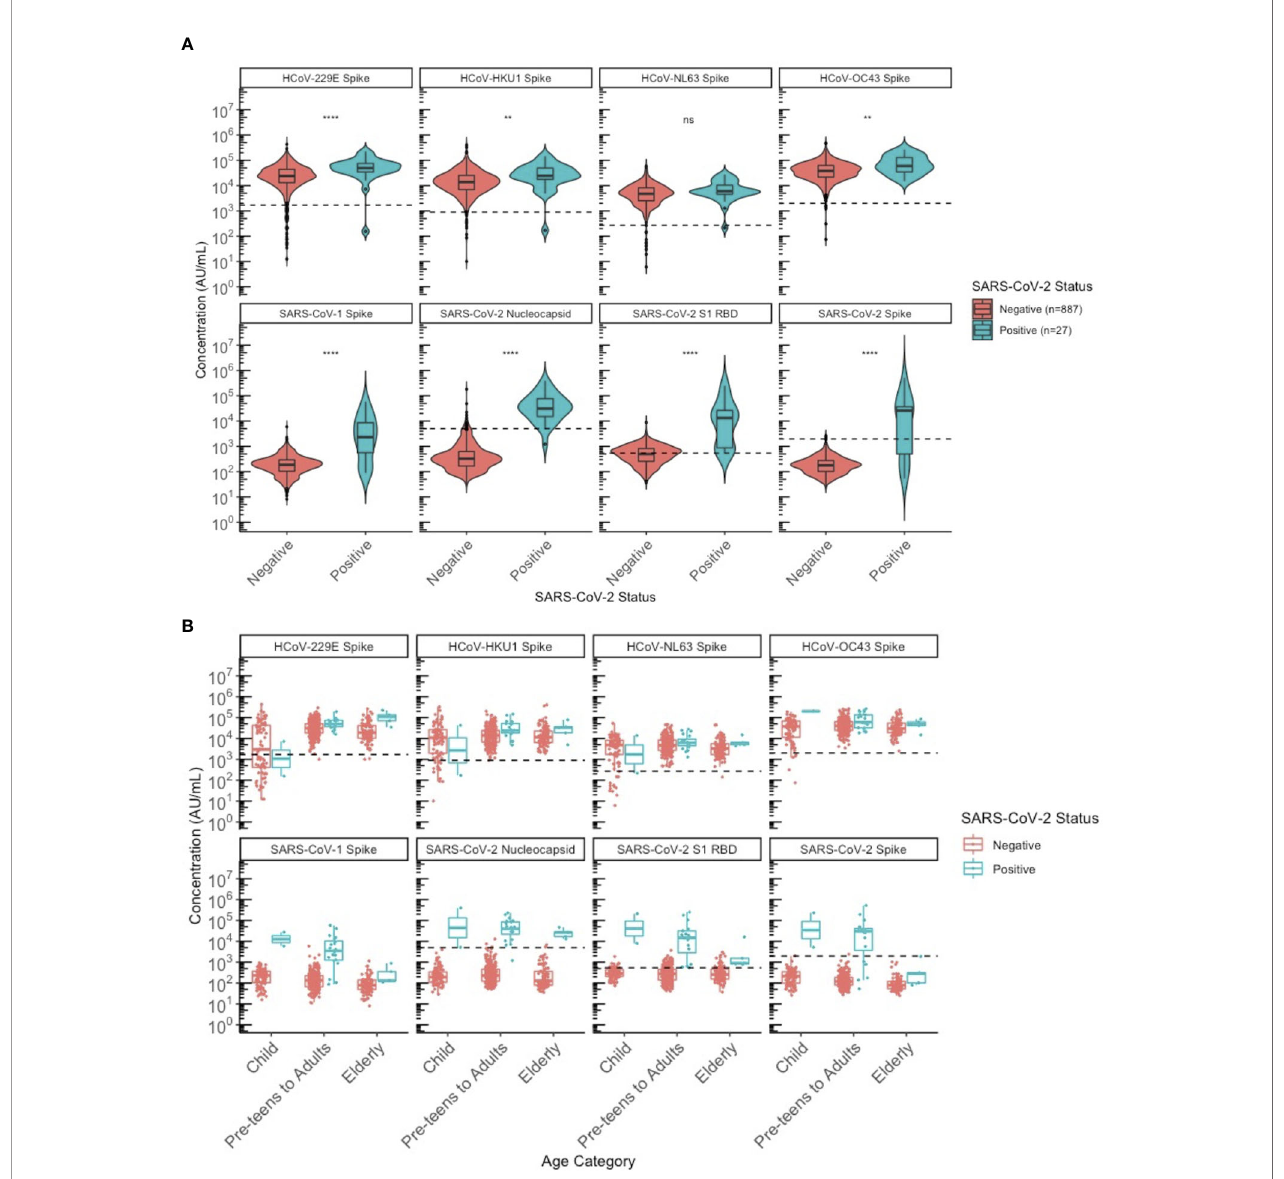
FIGURE 7 | Comparison of HCoV-speci fi c and SARS-CoV-2 speci fi c IgG antibody levels between SARS-CoV-2 sero-negative and sero-positive individuals. (A) describes the entire population from 2013 and 2020. All 2013 individuals were classi fi ed as sero-negative for SARS-CoV-2 status, regardless of whether they appeared SARS-CoV-2 sero-positive by MSD algorithm or not. (B) describes only the 2020 population strati fi ed by age category: children ( ≤ 10 years old), pre-teens to adults (11-69 years old), and the elderly ( ≥ 70 years old). SARS-CoV-2 sero-positive individuals include children (N = 2), pre-teens to adults (N = 20), elderly (N = 5); similar to SARS-CoV-2 sero-negative individuals where the distribution by age category is children (N = 88), pre-teens to adults (N = 295), elderly (N = 97). Black dashed lines describe the positivity cutoff for each antigen target. ns, not signi fi cant, ** = p < 0.01, **** = p <